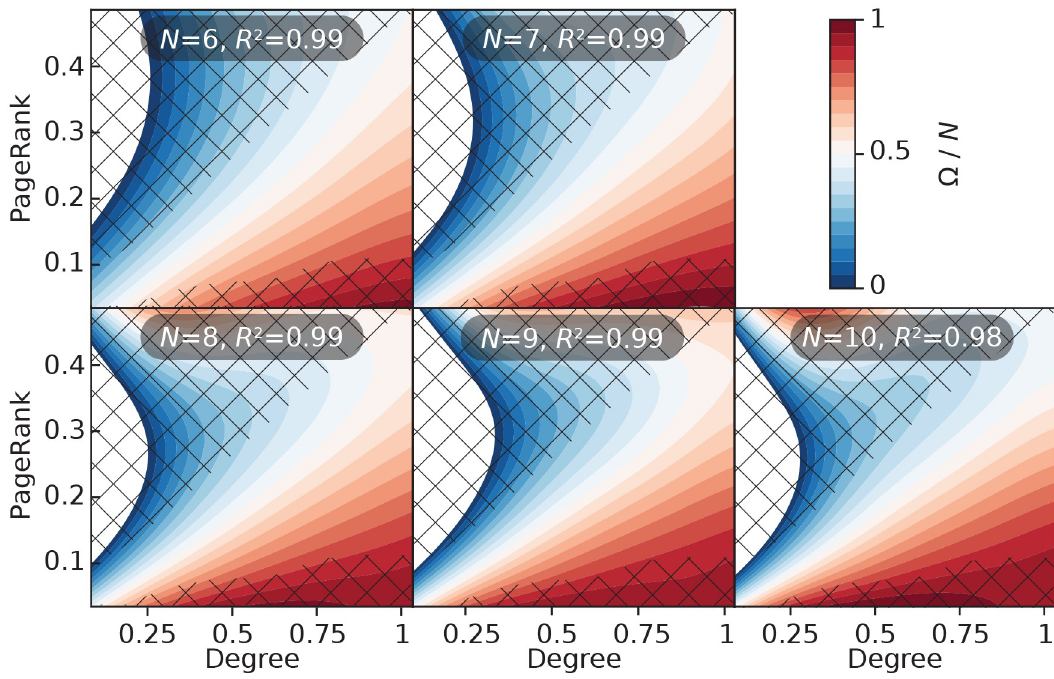
Fig 15. Prediction maps for the combination of PageRank and degree centrality for different graph sizes. This figure corresponds to Fig 13 but the transmission rate is fixed to β = 1 and we vary the system size. To be able to compare different systems sizes, we plot O / N rather than O